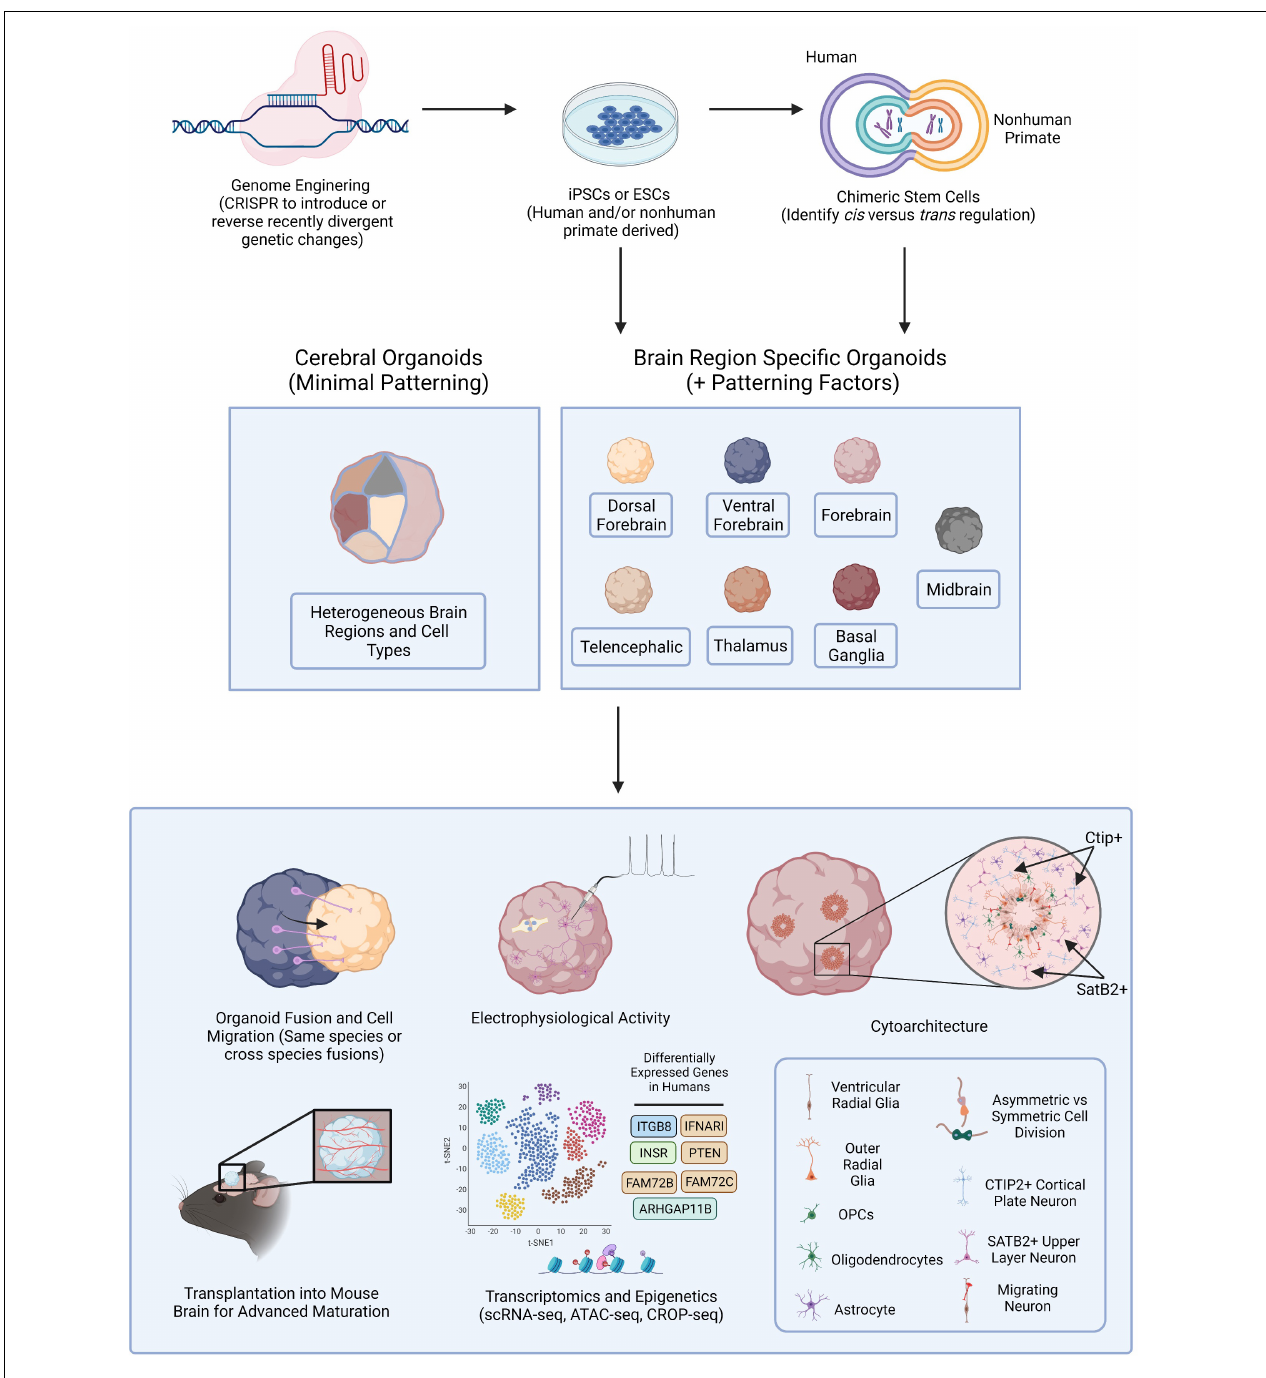
FIGURE 1 | Brain Organoid Based Models to Identify Human-Specific Processes of Brain Development. Schematic outlining the possible methods for establishing brain organoids from PSCs and various means of analysis and downstream processes to compare resulting phenotypes. PSCs can be obtained from either human or NHPs and CRISPR-Cas9, or other gene editing technologies, can be employed to introduce genetic perturbations into the PSCs. Cerebral or brain region specific organoids can then be directly generated from PSCs or human and NHP PSCs can first be fused forming tetraploid hybrid PSCs for the identification of cis vs. trans regulatory elements and then be applied for the generation of brain organoids. Cerebral organoids or several different types of brain region specific organoids can be produced from a variety of human and NHP PSCs. Different combinations of organoids can then be fused to observe neuronal migratory patterns important for establishing healthy brain connectivity. Resulting organoids can be implanted into the mouse brain for subsequent vascularization allowing for oxygen and glucose penetration into the organoid and advanced cellular maturation. Human specific phenotypes, including complex, functional cytoarchitectural differences or differentially expressed genes can then be identified through different means of analysis including monitoring of electrophysiological activity using MEA or with high-throughput omic analyses like scRNA-seq or ATAC-seq.